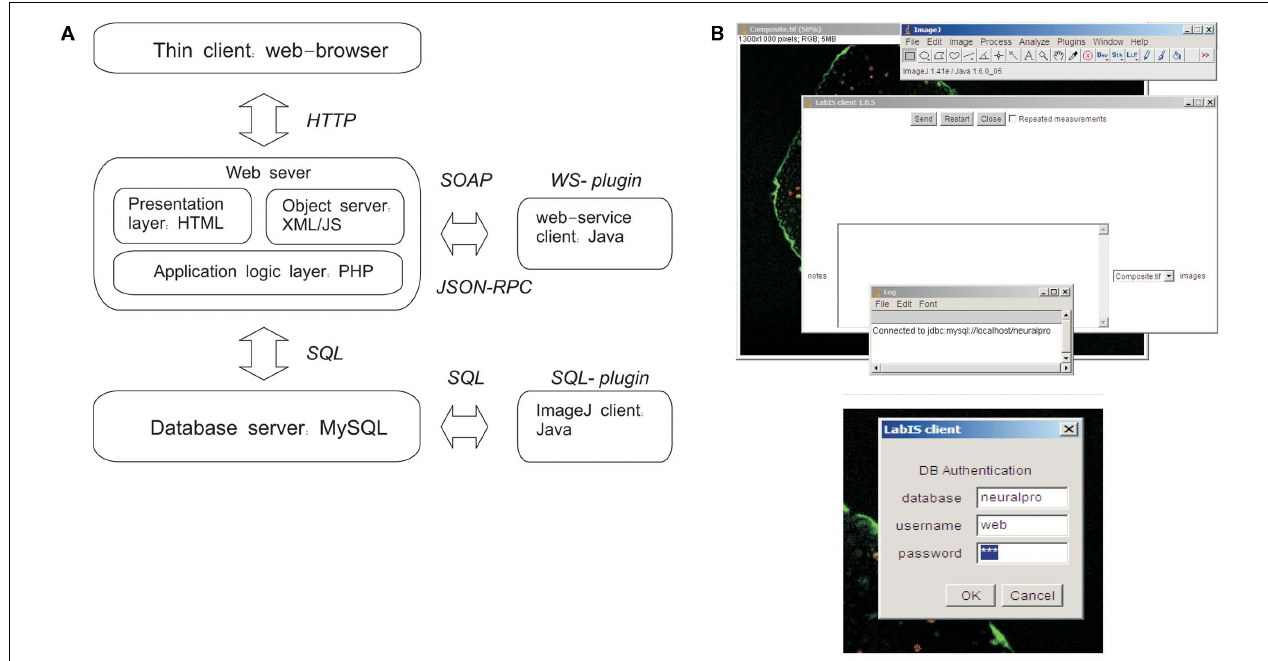
FIGURE 3 | LabIS : system architecture and data upload clients. (A) The information system can be accessed through the web UI by a web browser. Interactions with LabIS are executed either by exchange of SOAP messages (WS plugin) or by SQL queries (SQL-plugin). On the server side, the requests